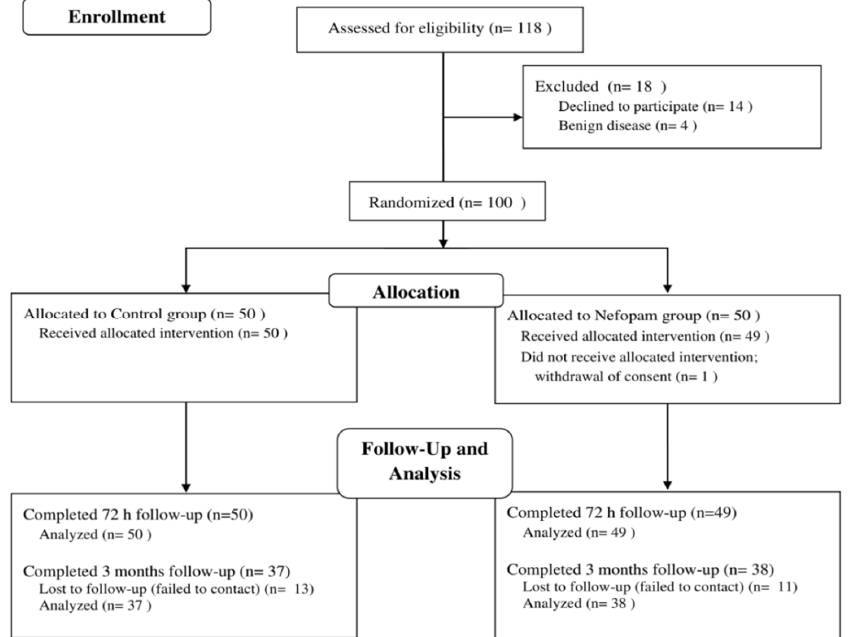
Figure 1. CONSORT flow diagram.